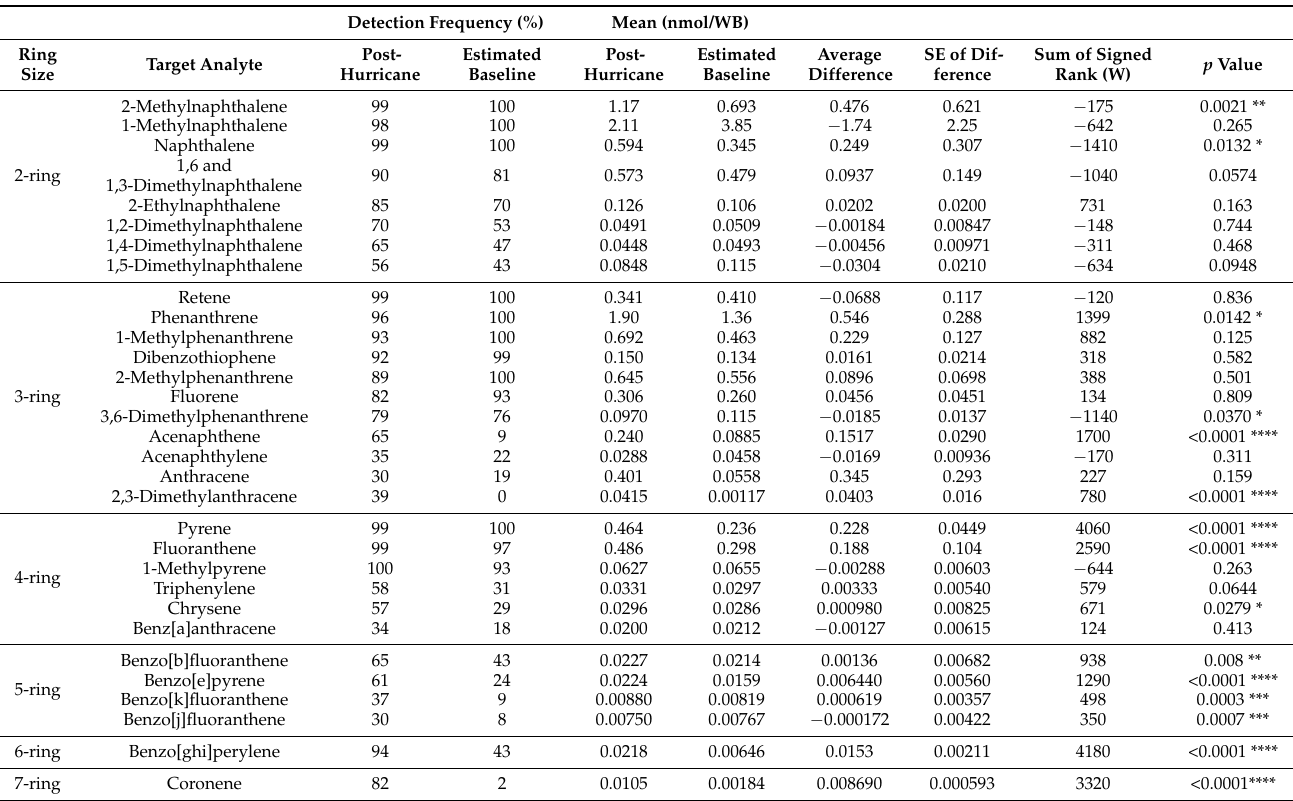
Table 2. Summary statistics including results from Wilcoxon matched-pair signed-rank tests for all detected analytes in the 63 PAH method, detected in more than 30% of the study population in at least one timepoint. Differences were calculated by subtracting individual estimated baseline concentrations from the paired post-hurricane concentration. Analytes are ordered in decreasing overall detection frequency across both